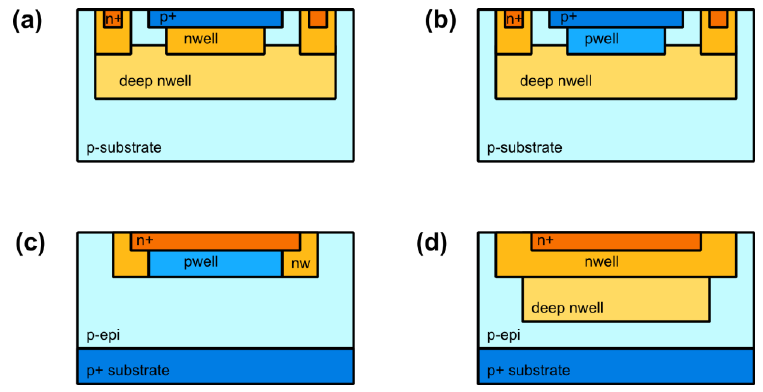
Figure 1. Cross sections of different CMOS SPAD devices ( a ) p+/nwell; ( b ) pwell/deep-nwell; ( c ) n+/pwell; ( d ) deep-nwell/p-epi/p+ sub. ( c ) n+/pwell; ( d ) deep-nwell/p-epi/p+